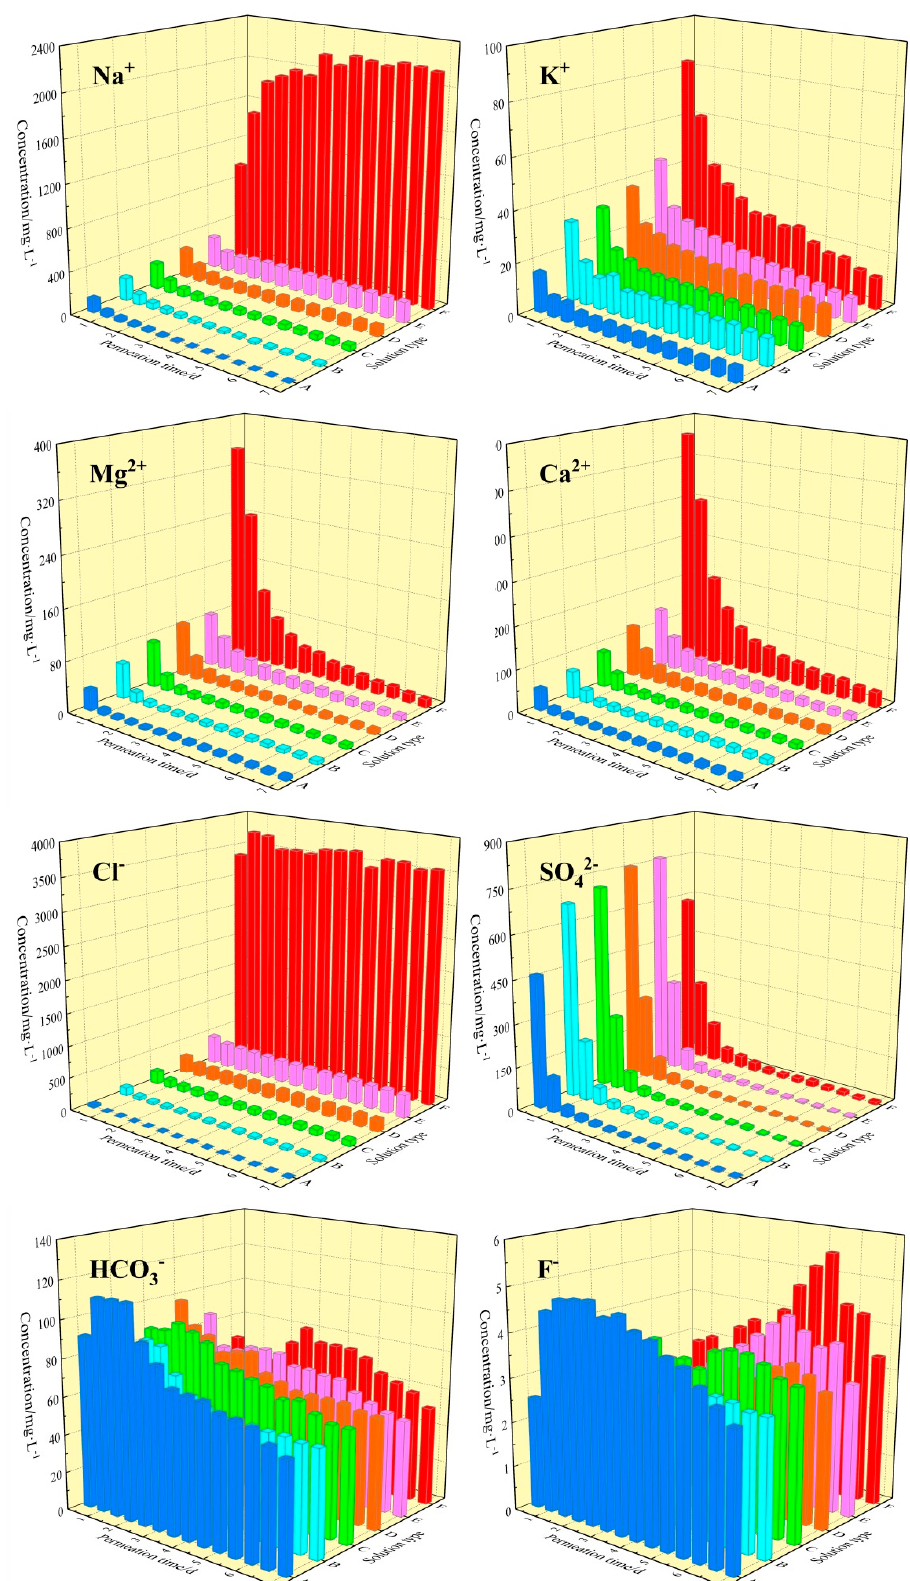
Figure 5. Change characteristics of the chemical components of the leachate with time. Solution types of A, B, C, D, E, and F represent 0, 0.001, 0.0025, 0.005, 0.01, and 0.1 mol/L, respectively.